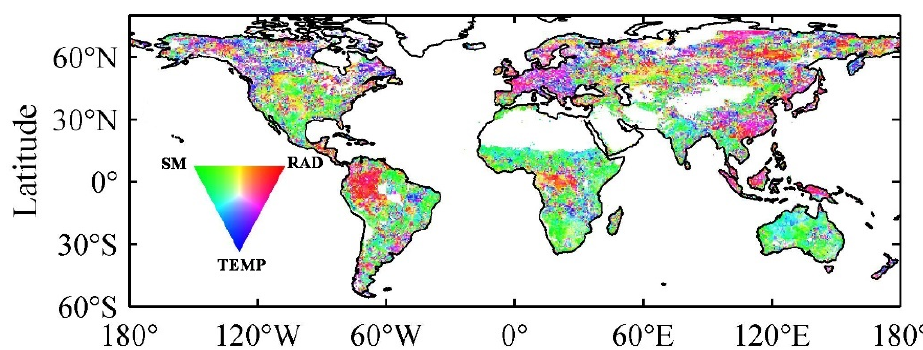
Figure 3. Geographic distributions of potential climate factors (temperature, radiation and soil moisture) to GPP from 1982 to 2015.